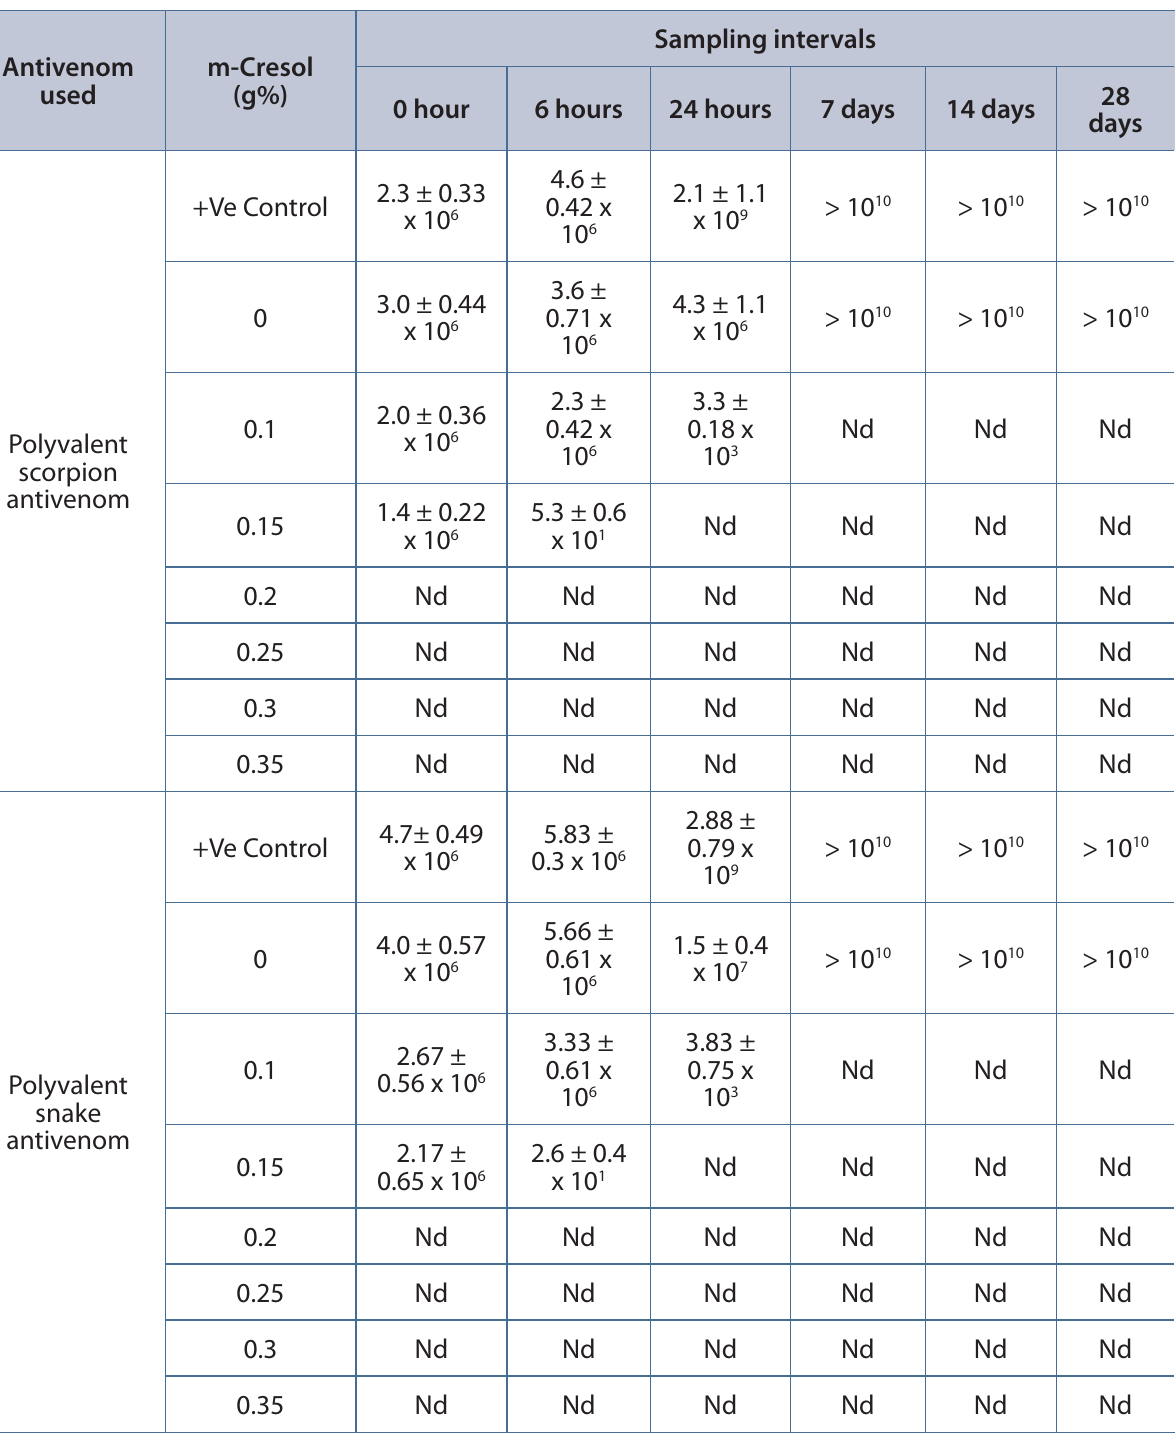
Values represent the mean of six samples followed by their respective standard error of the mean. CFU: colony-forming unit; Nd: not